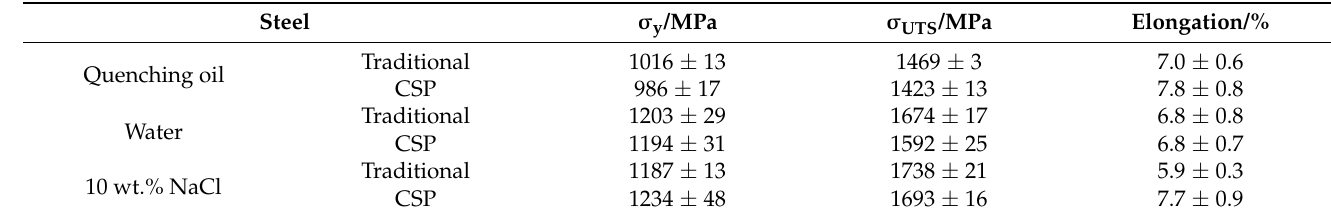
Figure 2. Mechanical properties of traditional and CSP processes produced steels: ( a ) engineering stress–strain curve of the original samples and ( b ) engineering stress–strain curve after quenching by a different quenching medium. Table 2. Mechanical property parameters of hot-stamping steel produced by traditional and CSP processes after quenching include yield strength ( σ s ), tensile strength ( σ b ), and total elongation (E total ).